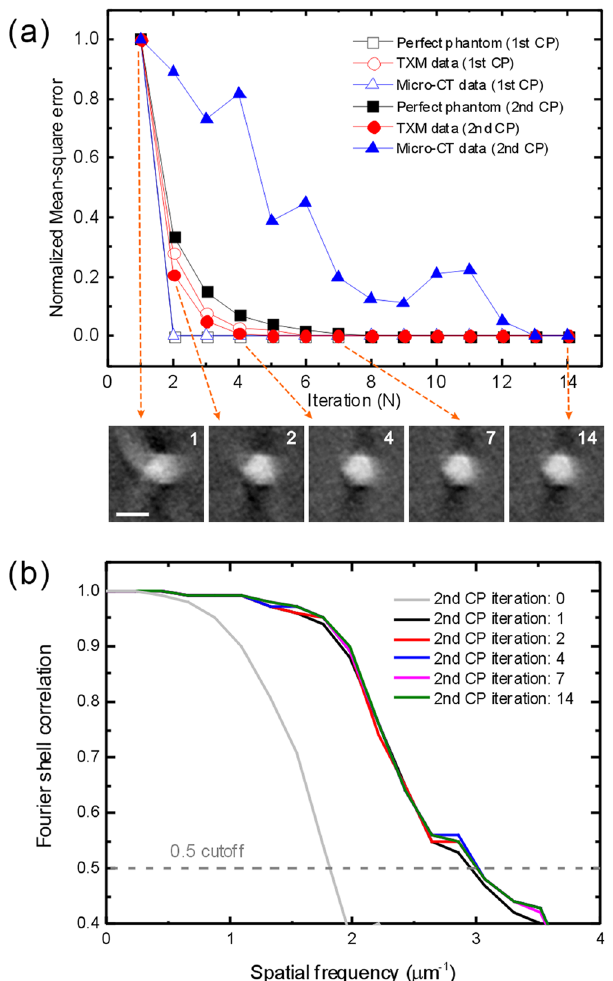
Figure 8. Convergence of Faproma algorithm. ( a ) Comparison of the normalized mean-square error and iteration times among various 3D tomography datasets. The inserted images show the resulted reconstruction quality with different registration iteration times using Faproma second correction process (see Supplementary Movie S5). ( b ) Three-dimensional Fourier shell correlation among different iteration times by the second correction process of Faproma. CP: correction process. Scale bar is 1 μ